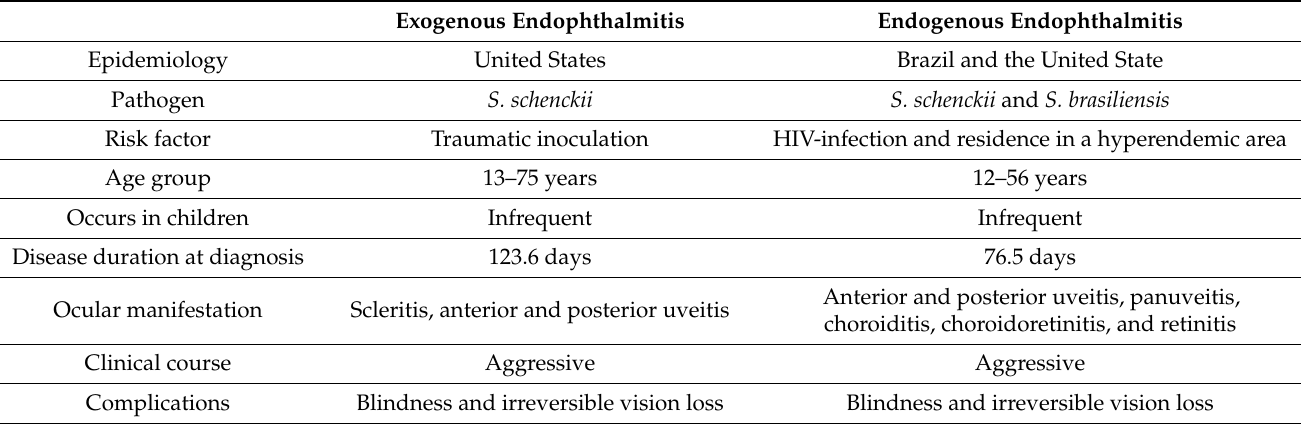
Table 5. Comparison between the exogenous and endogenous endophthalmitis due to Sporothrix [9]. Exogenous Endophthalmitis Endogenous Endophthalmitis Epidemiology